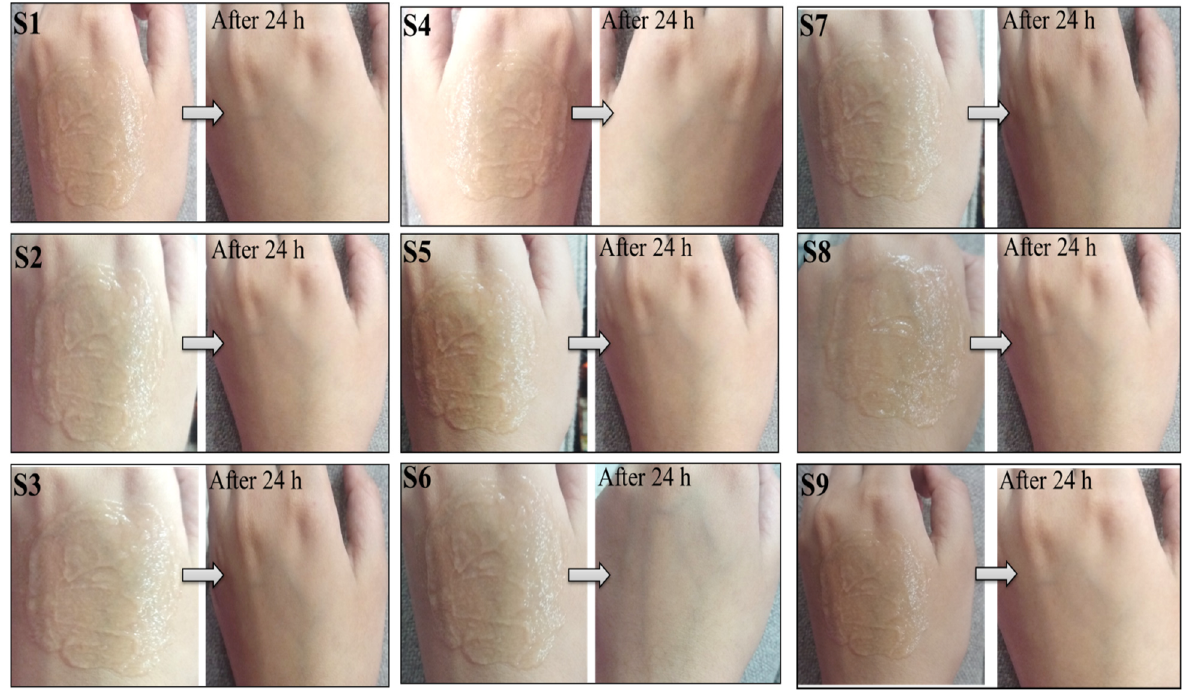
Figure 6. During the study period of 24 h, no redness, edema, irritation, or any other negative effect was observed. was